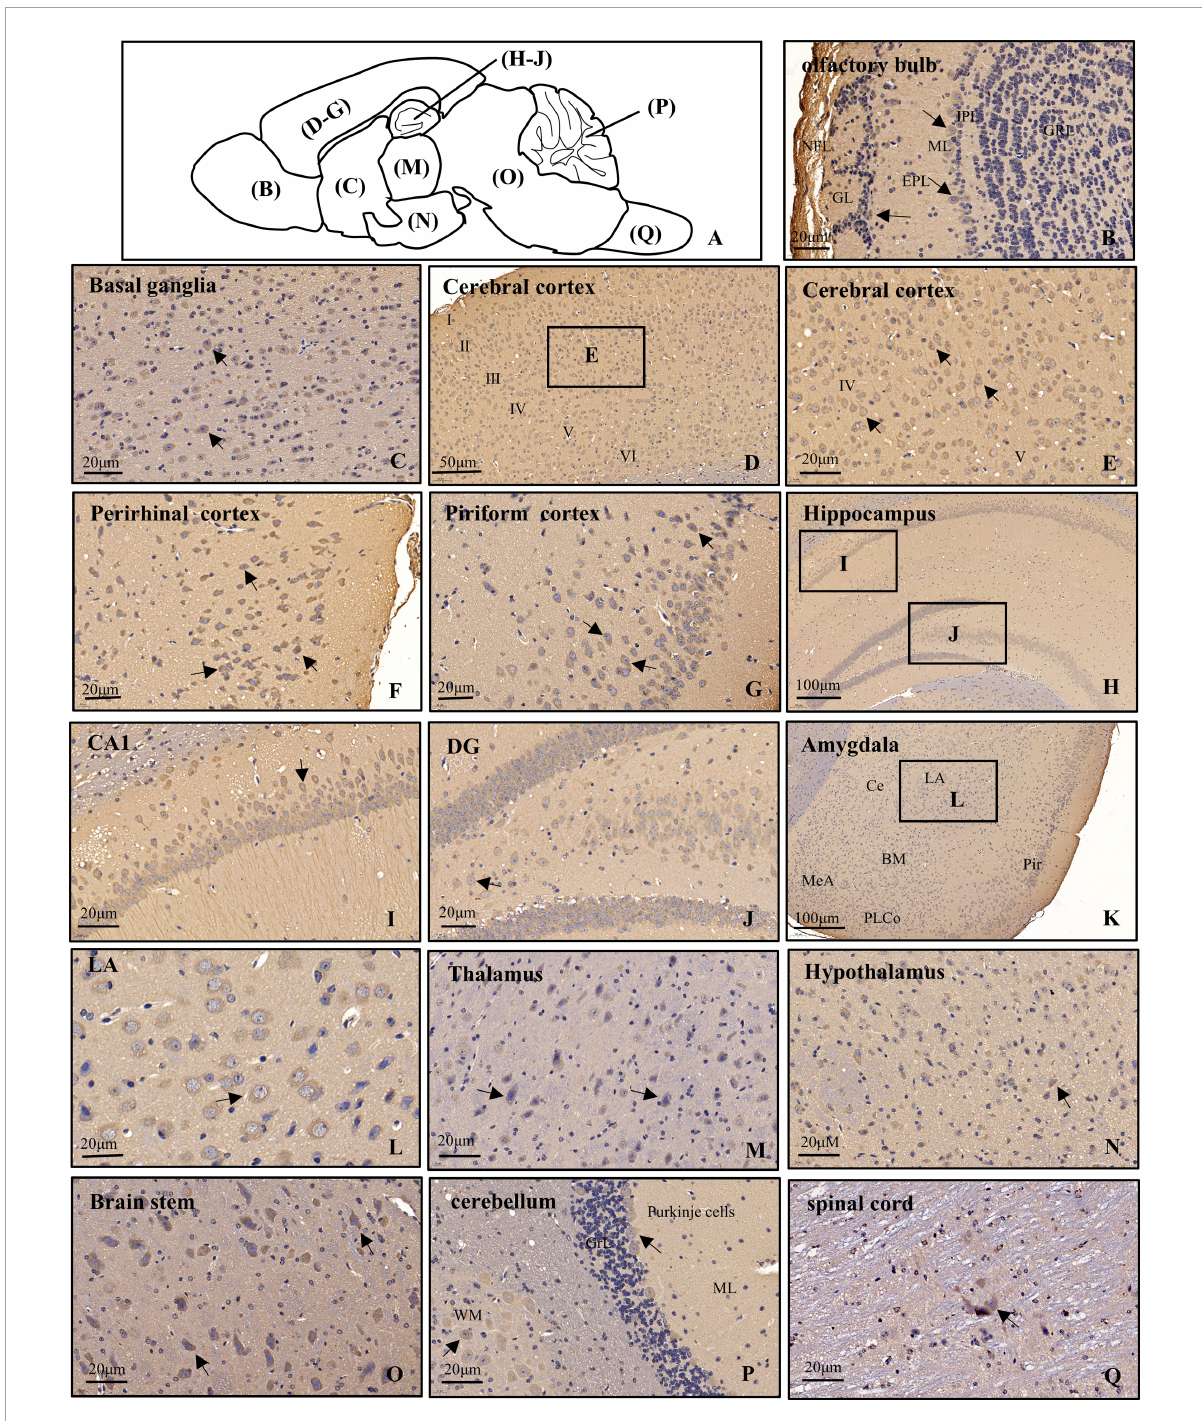
FIGURE3 Distribution of POMGNT1 in the brain and spinal cord of the adult mouse. (A) Drawing with the location of the different brain regions shown in panels (B–Q) . The representative expression pattern of POMGNT1 in the coronal brain sections of the brain and spinal cord: (B) olfactory bulb, (C) basal ganglia, (D–G) cerebral cortex, (H–J) hippocampus, (K,L) amygdala, (M) thalamus, (N) hypothalamus, (O) brain stem, (P) cerebellum, and (Q) spinal cord. The hematoxylin stained nucleus is blue, and the positive expression of POMGNT1 is brownish-yellow. Arrows indicate representative POMGNT1-positive neurons. N = 6 mice. Scale bars = 20 µ m (B,C,E–G,I,J,L–Q) or 50 µ m (D) , or 100 µ m (H,K) . NFL, olfactory nerve fiber layer; GL, glomerular layer; EPL, external plexiform layer; ML, mitral cell layer; IPL, internal plexiform layer; GRL, granule cell layer; DG, dentate gyrus; LA, lateral amygdaloid nucleus; CeA, central amygdaloid nucleus; BM, basomedial amygdaloid nucleus; MeA, medial amygdaloid nucleus; PLCo, posterolateral cortical amygdaloid nucleus; Pir, piriform cortex; ML, molecular layer; GrL, granular layer; WM, white